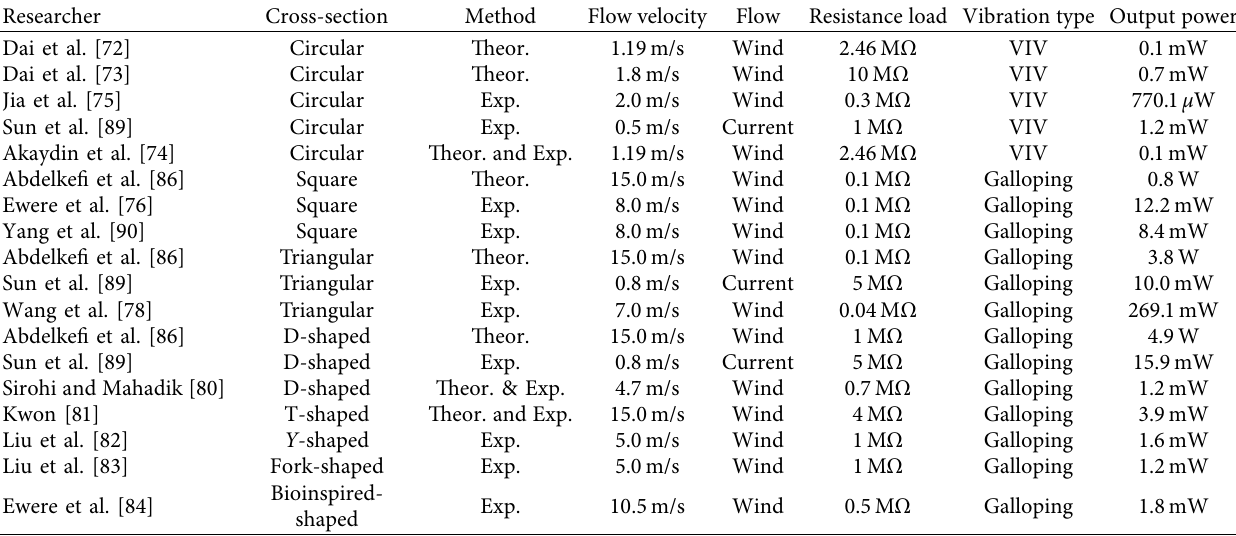
Table 4: Summary of the effect of cross-section of bluff body on piezoelectric energy harvester. Researcher